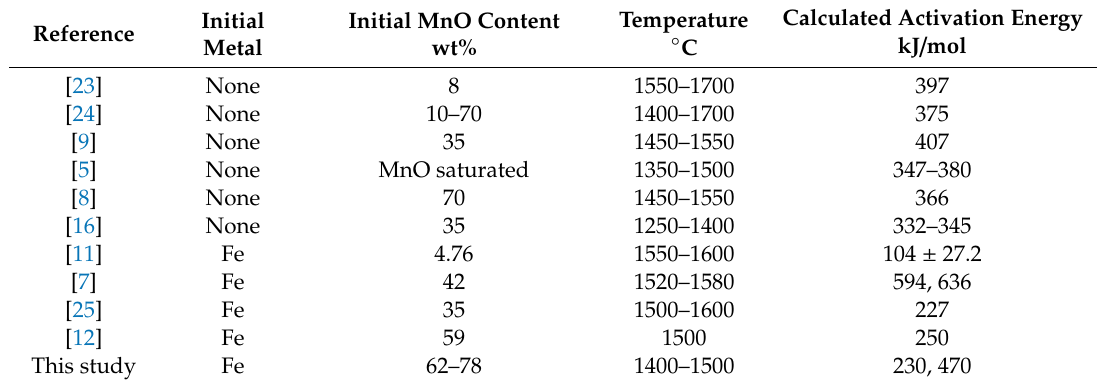
Table 5. Reported activation energies for MnO reduction by carbon.